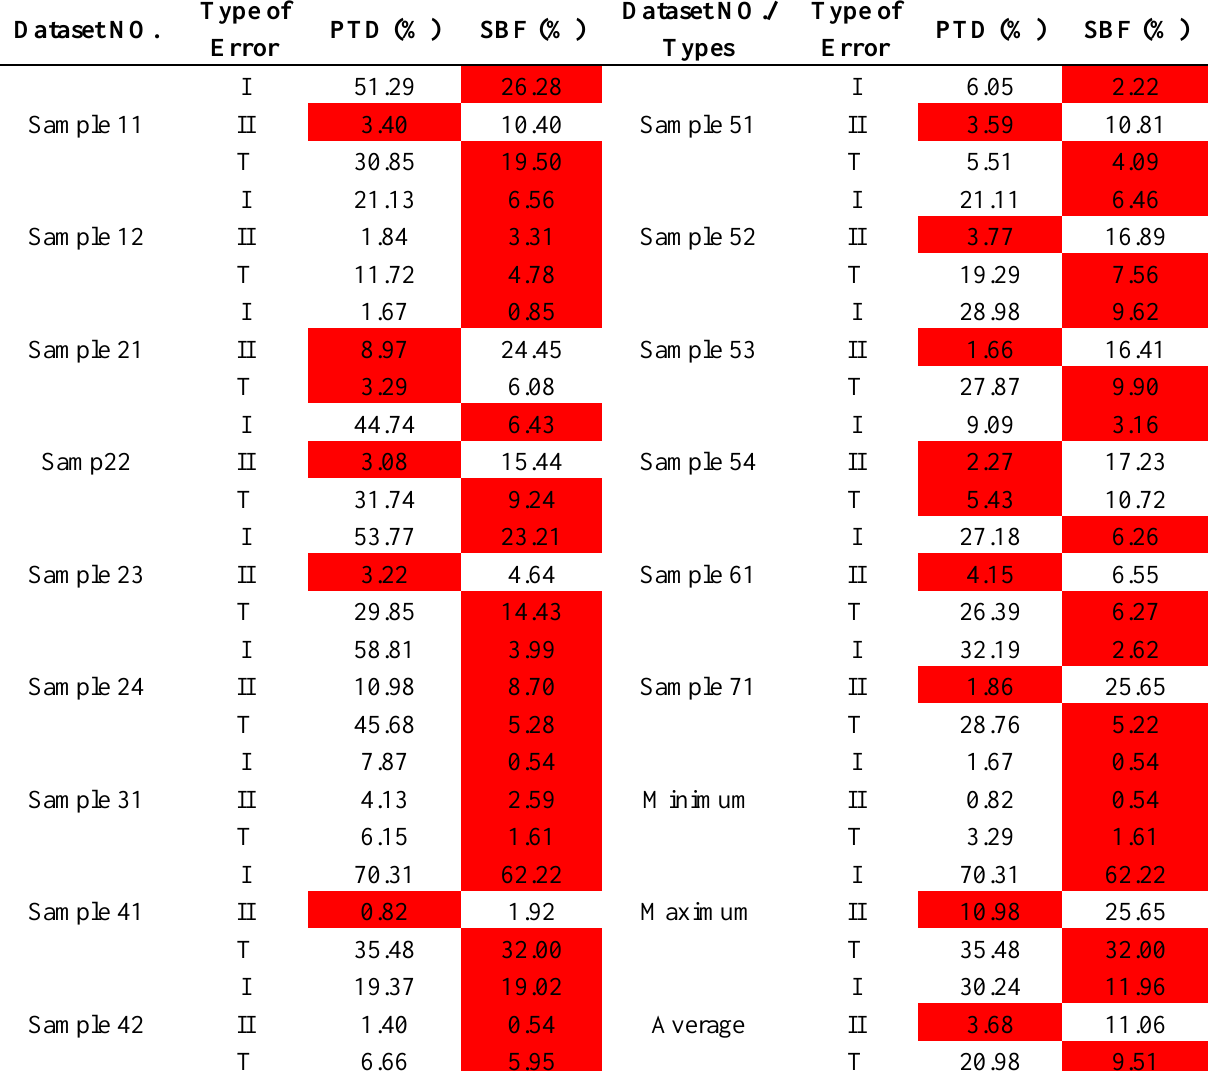
Table 3. Three types of errors of the two filters, i.e. , PTD method and SBF method. Dataset